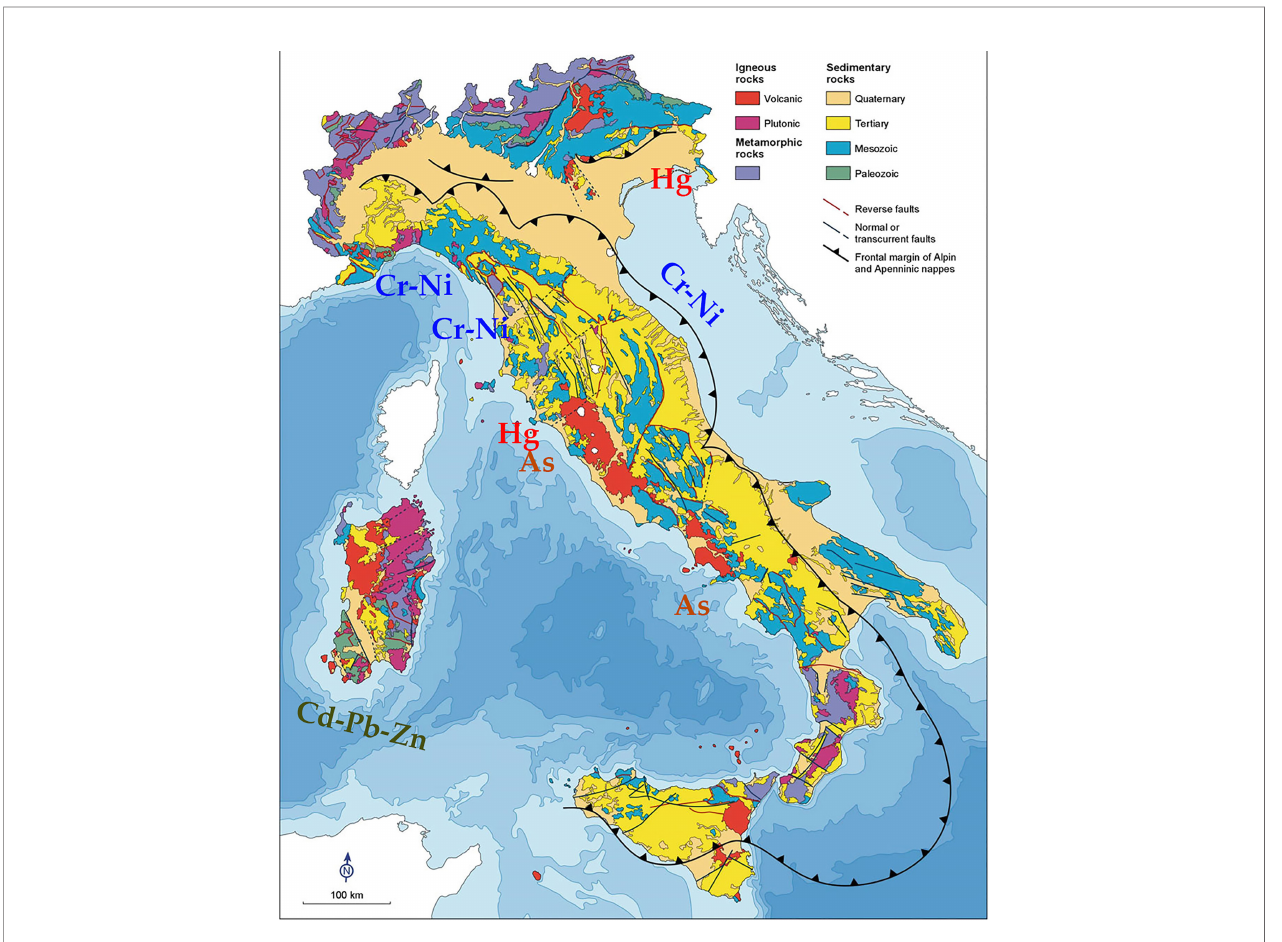
FIGURE 1 | Italy ’ s simpli fi ed geological map; the chemical symbols of enrichments elements in marine sediments have been added (modi fi ed from Bosellini,